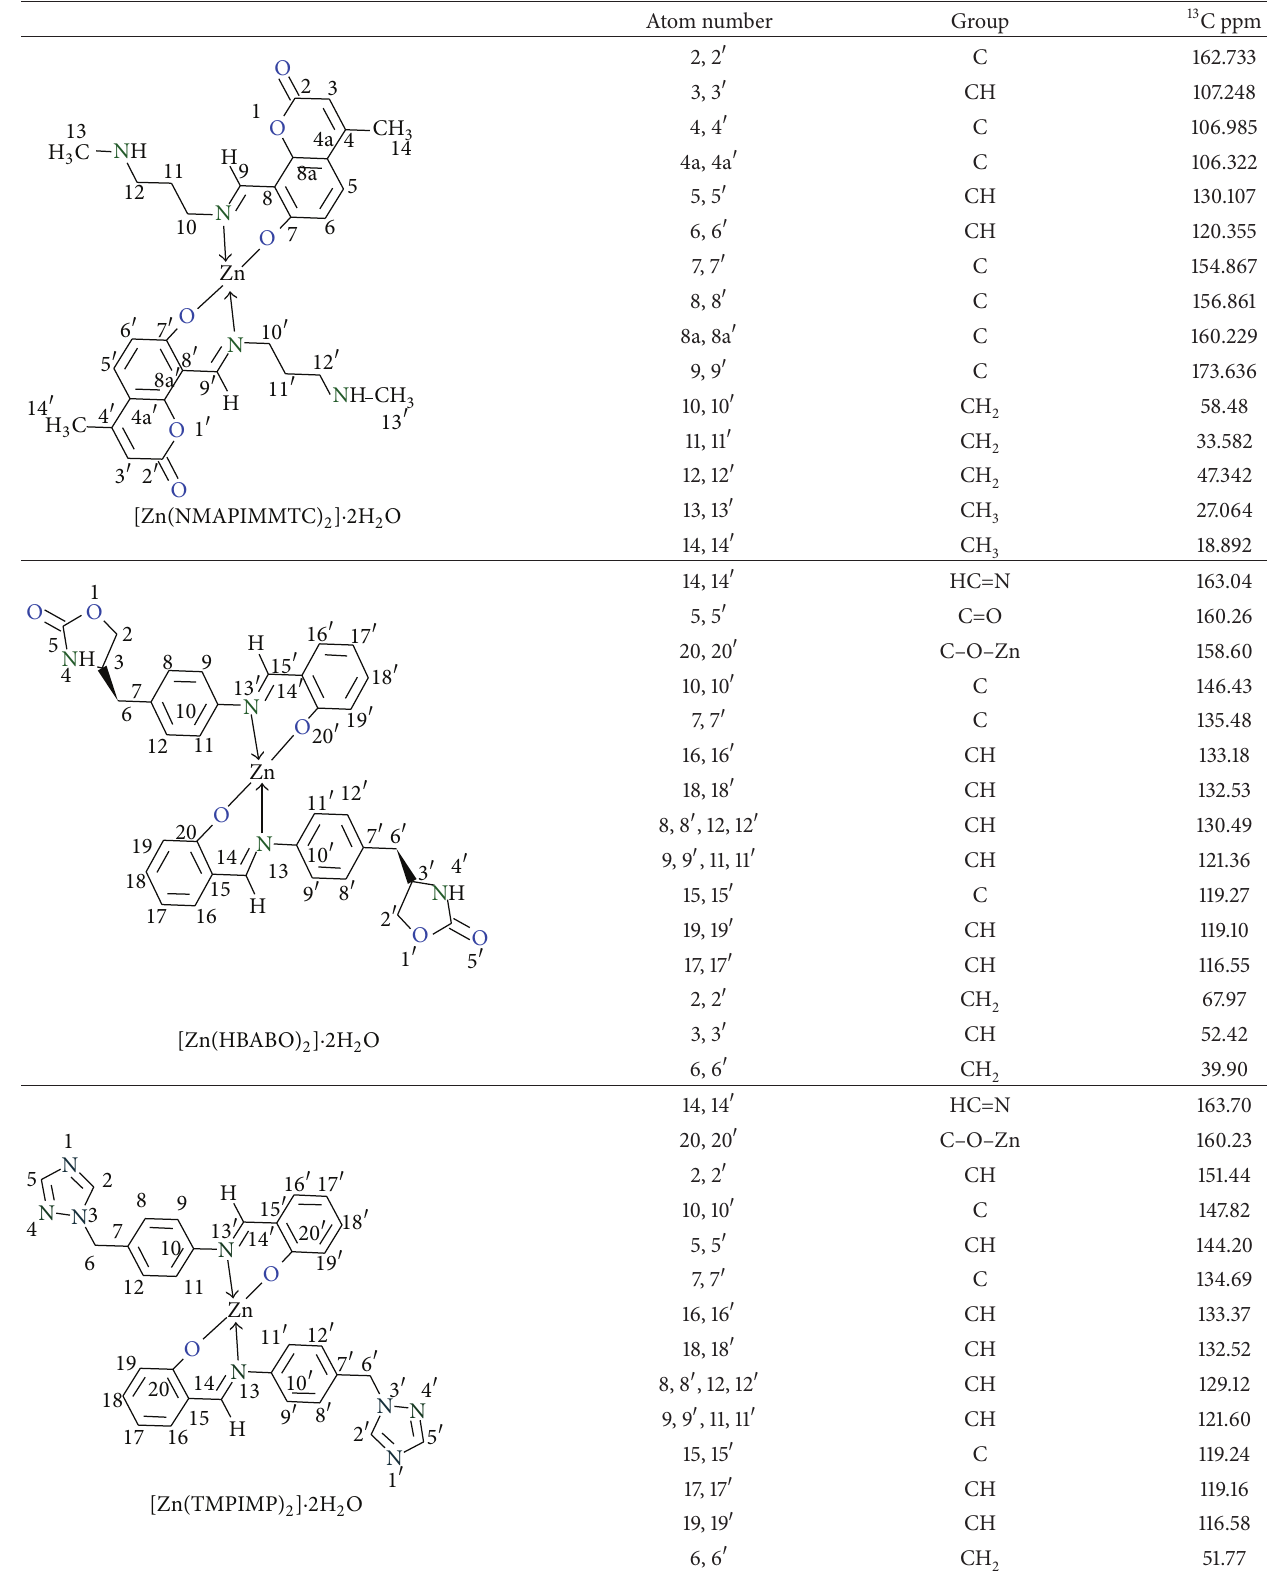
Table 1: 13 C NMR assignments of metal